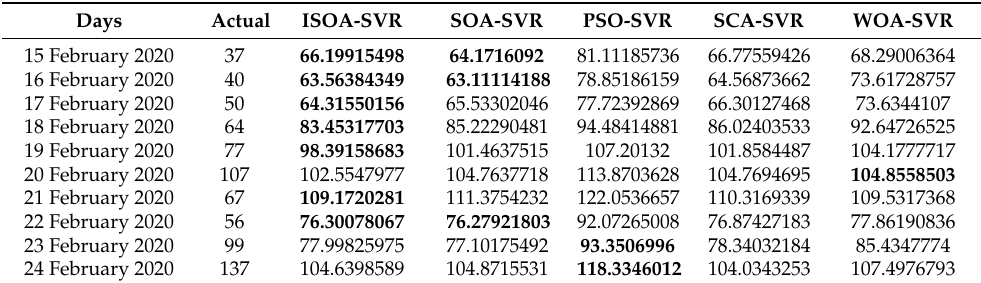
Table 12. The predicted value of the monthly average AQI index of Taiyuan in 10 days (15 Febru-